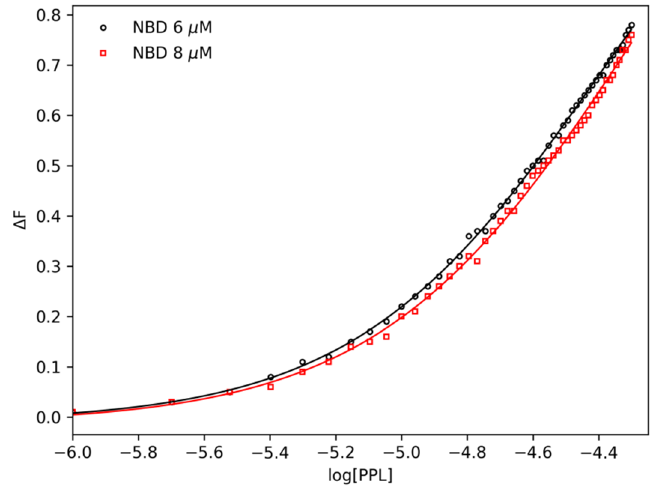
Figure 5. Plot of ∆ F versus Log [ PPL ] obtained from PPL titration experiments with NBD concentra- tions of 6.0 µ M and 8.0 µ M at 293 K.